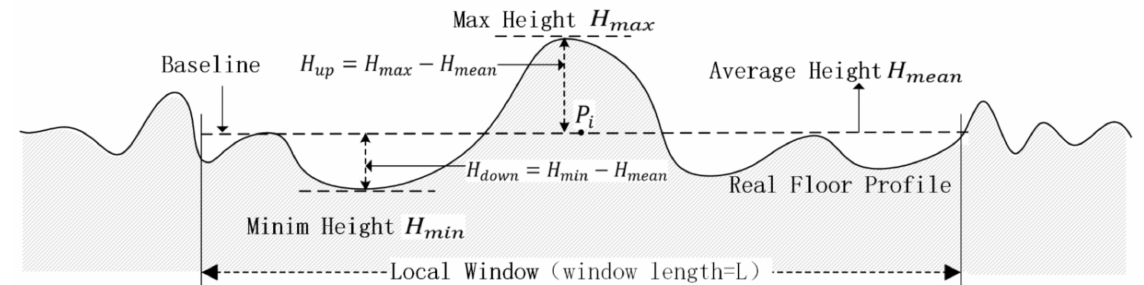
Figure 1. Flatness and its measurement